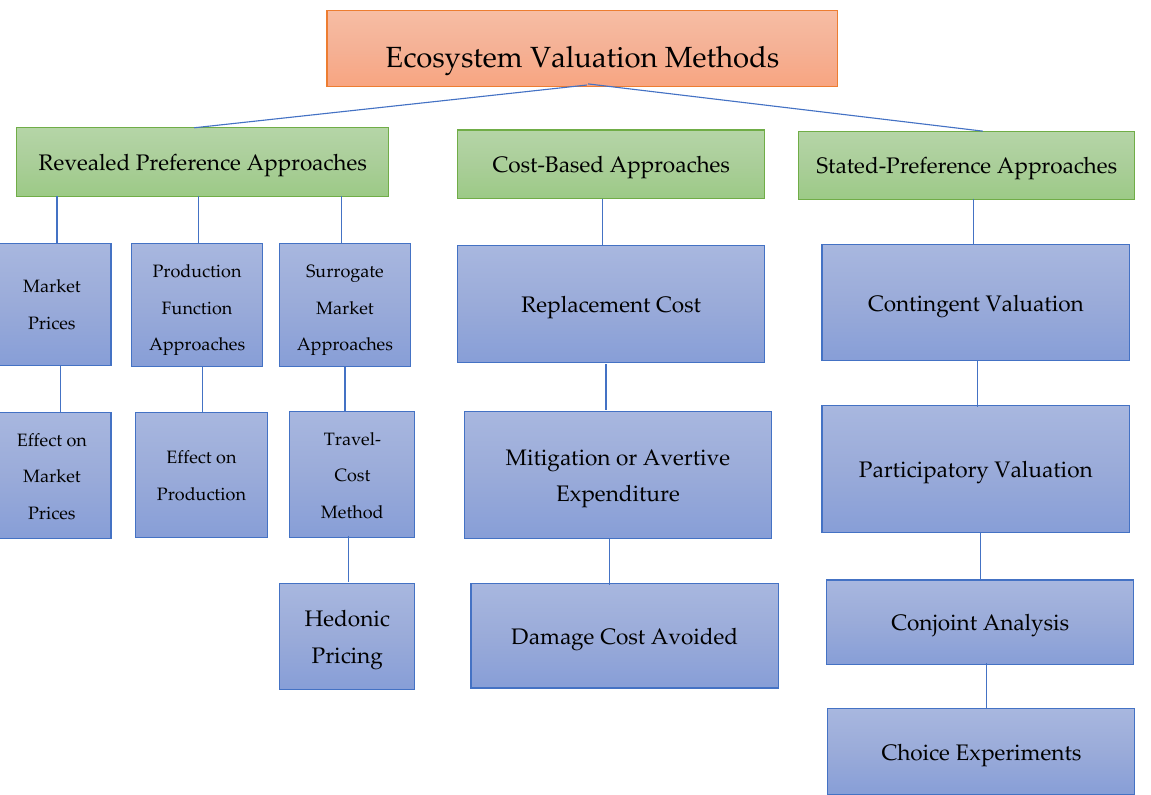
Figure 1. Categories of commonly used ecosystem valuation methods. The data was adapted, and revised as intended. It was obtained with permission from a public domain publication. Publisher: IUCN, Copyright year: 2004, Source : Emerton and Bos [33].